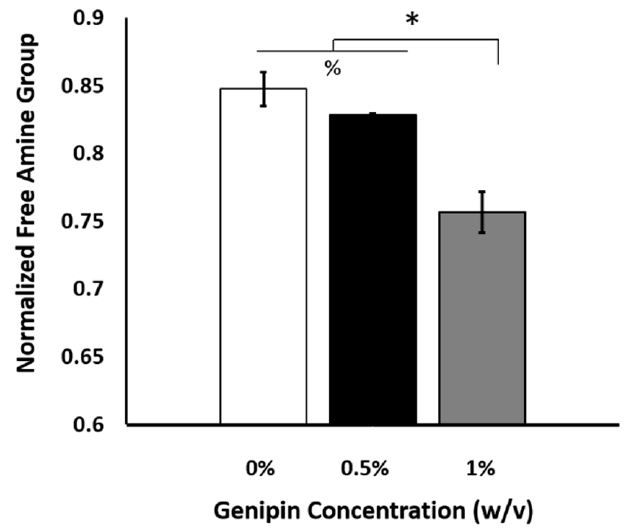
Figure 3. The changes in the scaffolds’ degree of crosslinking with the increased genipin concentration. (*) indicates a significant difference between the experimental groups, p < 0.05 while (%) indicates a significant difference between the experimental groups, p < 0.01.